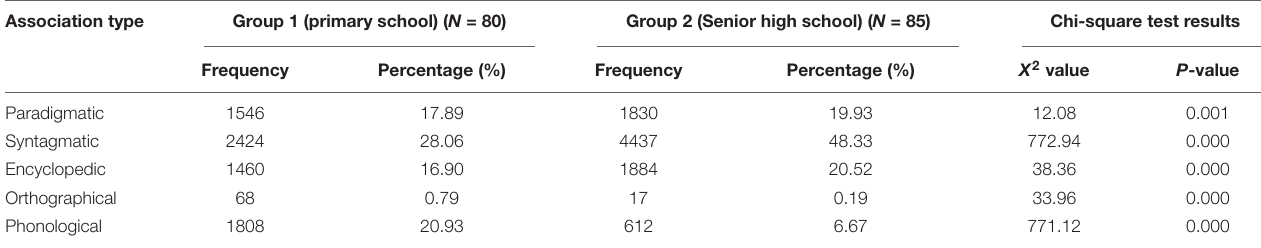
TABLE 4 | The results of word association at the second layer. Association